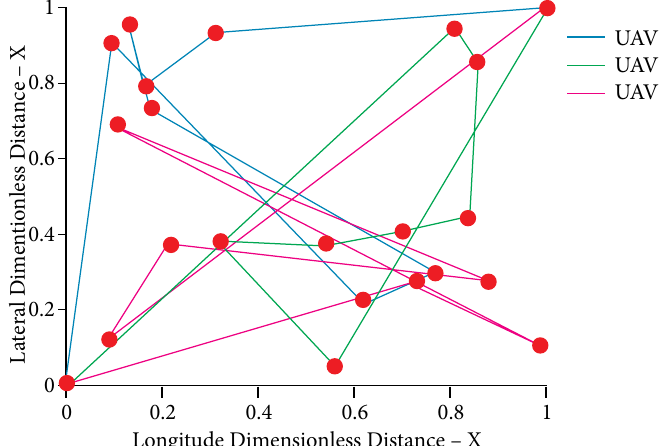
Figure 6. The first iteration for 3 UAVs patrolling.